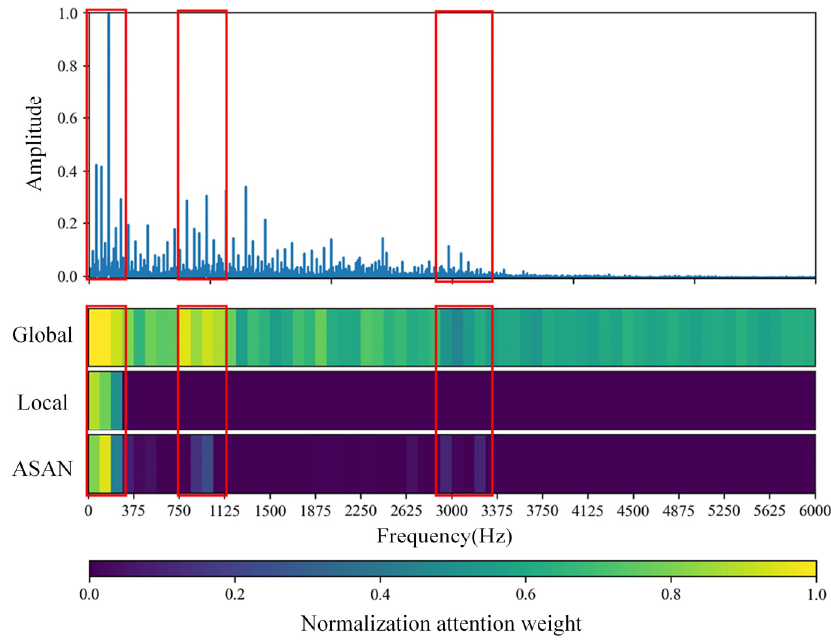
Figure 9. The average attention of each method to the bearing envelope